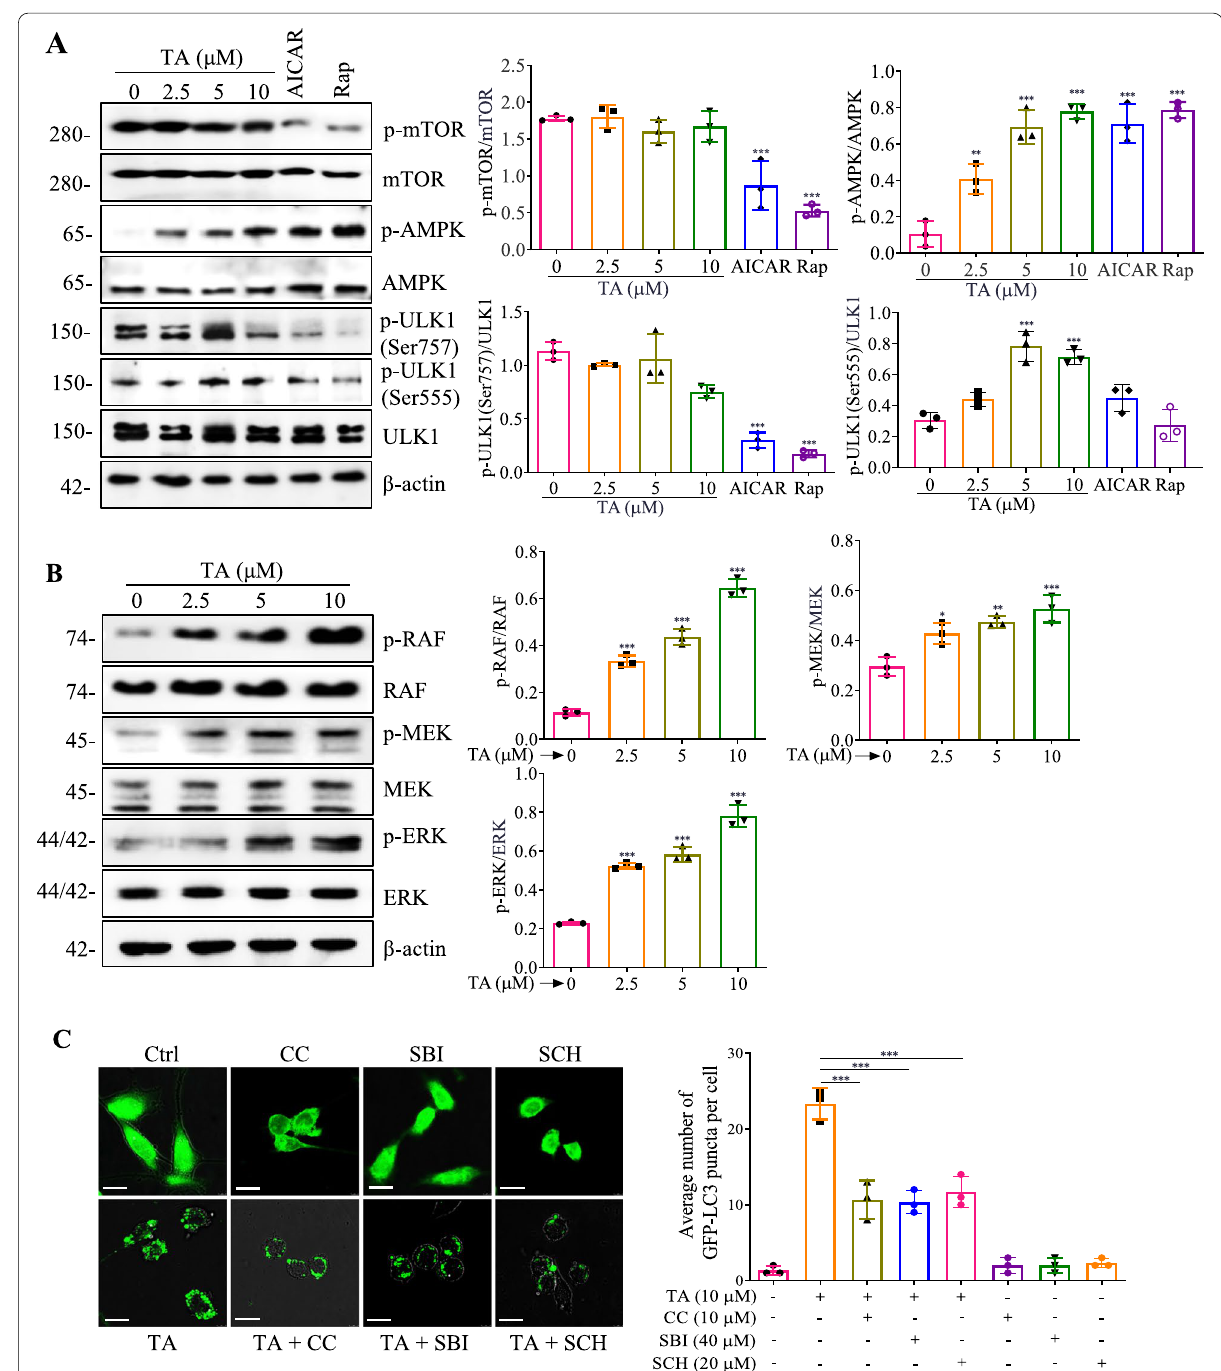
Fig. 2 TA induces autophagy via activating the AMPK/ULK1 and Raf/MEK/ERK signaling pathways. A BV‑2 cells were treated with 2.5, 5, and 10 μM of TA, AICAR (1 mM), or Rap (0.5 μM) for 24 h. Then protein expressions were detected using Western blot. Bar charts indicate the ratios of p‑mTOR/ mTOR, p‑AMPK/AMPK, p‑ULK1 (Ser757)/ULK1, and p‑ULK1 (Ser555)/ULK1 in BV‑2 cells. B BV‑2 cells were treated with TA at indicated concentrations for 24 h. Then protein expressions were detected using Western blot. Bar charts indicate the ratios of p‑Raf/Raf, p‑MEK/MEK, and p‑ERK/ERK in BV‑2 cells. C Representative fluorescence images of BV‑2 cells transfected with GFP‑LC3 plasmid and pretreated with CC (10 μM) or SBI (40 μM) or SCH (20 μM) for 1 h, followed by treatment with TA (10 μM) for an additional 24 h were captured. Magnification, the average number of GFP‑LC3 puncta per cell. Error bars, S.D. * p post hoc t ‑tests for multiple comparisons was applied for comparison between groups). The full‑length blots are presented in Additional file 1: Fig.